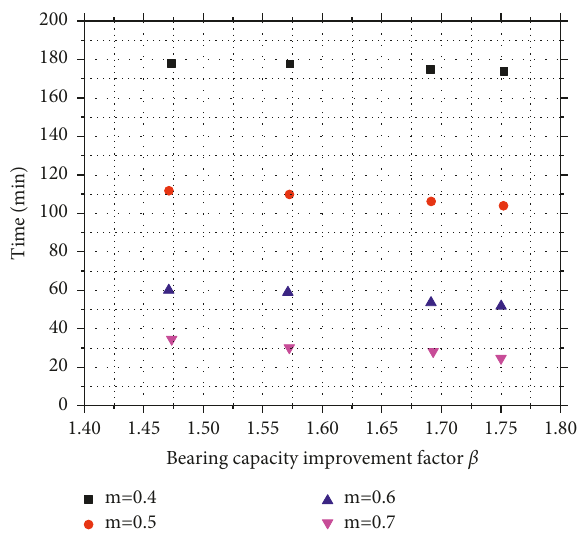
Figure 6: The effect of different bearing capacities on the fire resistance of the steel